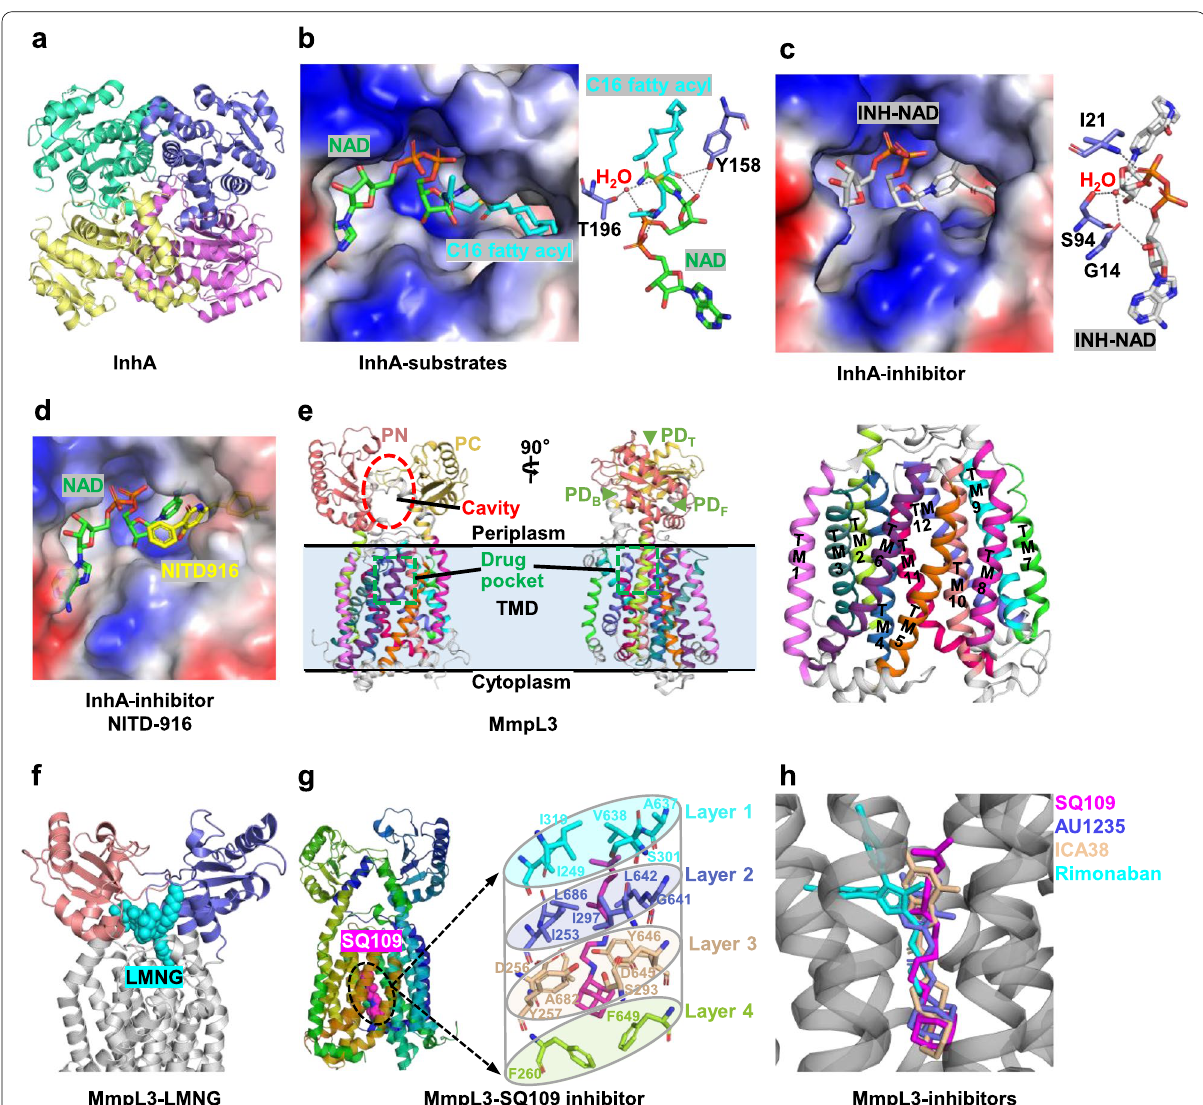
Fig. 2 Enzymes associated with mycolic acid biosynthesis. a Overall structure of Enoyl-acyl carrier protein reductase (InhA, PDB ID: 4TRM). b Structure of the C16 fatty acyl and NAD substrates bound to InhA protein (PDB ID: 1BVR). Hydrogen bonds between the active site of InhA and + the bound C16 fatty acyl substrate are shown as gray dashes drawn between interacting atoms. c Structure of InhA protein with the INH-NAD adduct (PDB ID: 2IDZ). The oxygen O9 of the phosphate of the INH-NAD adduct forms a hydrogen bond with the main-chain nitrogen atom of Ile21 and a hydrogen bond with a well-ordered water molecule. The water molecule is part of a hydrogen-bonding network formed by interactions between the side-chain oxygen atom of Ser94, the main-chain oxygen of Gly14 and the oxygen atoms O3 and O9 of the INH-NAD adduct. The same water molecule is within hydrogen-bonding distance of the main-chain nitrogen atoms of Ile21. d Electrostatic surface of InhA in a complex with inhibitor NITD-916. e Cartoon representation of the MmpL3 crystal structure. The subdomain PN and PC intertwine to create a central cavity, which connects to three openings, a funnel at the top (PDT), an opening in the front (PDF) and an opening at the back (PDB) of the headpiece. TMD, transmembrane domain. f Structure of MmpL3 in a complex with lauryl maltose neopentyl glycol (LMNG). g MmpL3 inhibitor binding pocket for SQ109. The four layers of residues surround SQ109 like a cylinder. h Superposition of SQ109-bound, AU1235- bound, ICA38-bound, and Rimonabant-bound structures. It shows that all the inhibitors have similar binding positions. The electrostatic potential in all figures was computed using the APBS tools in PyMol (http:// www. pymol.